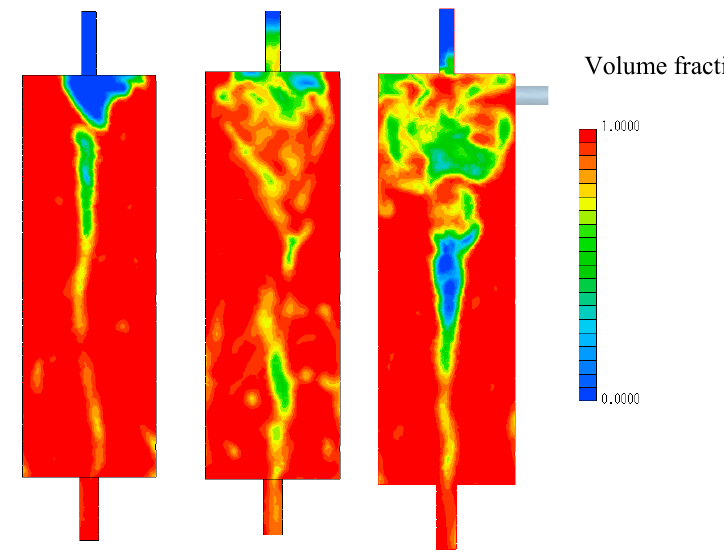
Figure 13. CAE analysis results of volume fraction under lateral acceleration .